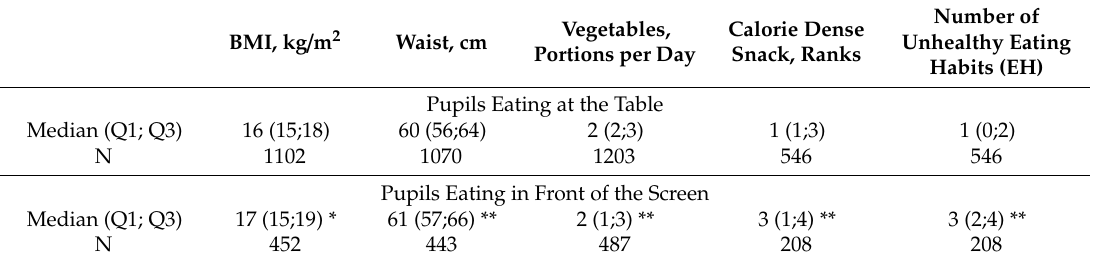
Table 3. Anthropometric parameters and eating habits in pupils eating at the table or in front of the screen.